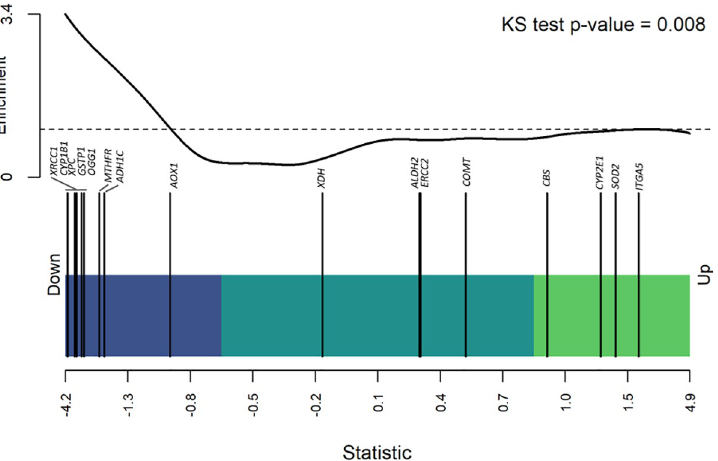
Fig 1. Gene-set enrichment analysis for gene expression across vital status. The x -axis corresponds with the sorted effects of vital status, estimated assuming the following probabilistic model y 0 z for the expression of 19,535 genes. The light green and blue rectangles represent the up and A x C þ Z S x A x C þ ε g g g down regulation regions defined by the third and first quartile, respectively. The vertical bars represent a target set of genes involved in alcohol metabolism. The black curve shows the estimated running enrichment score, and the dashed line shows the threshold for random disposition of the target set. The p-value was obtained by modified Kolmogorov- Smirnov (KS) test over the maximum value of the enrichment score. Genes in the target set: XRCC1 , CYP1B1 , XPC , GSTP1 , OGG1 , MTHFR , ADH1C , AOX1 , XDH , ALDH2 , ERCC2 , COMT , CBS , CYP2E1 , SOD2 , and ITGA5 .